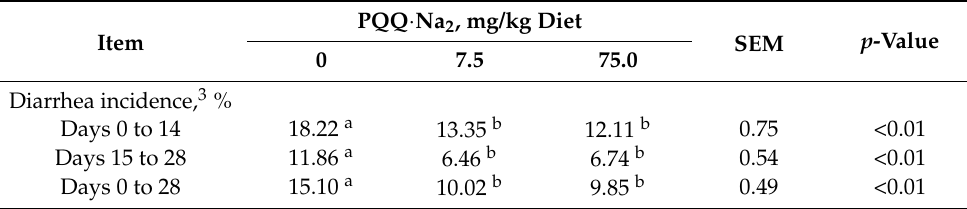
Table 3. Incidence of diarrhea in weaned pigs fed graded levels of PQQ · Na 2 1 for 28 day